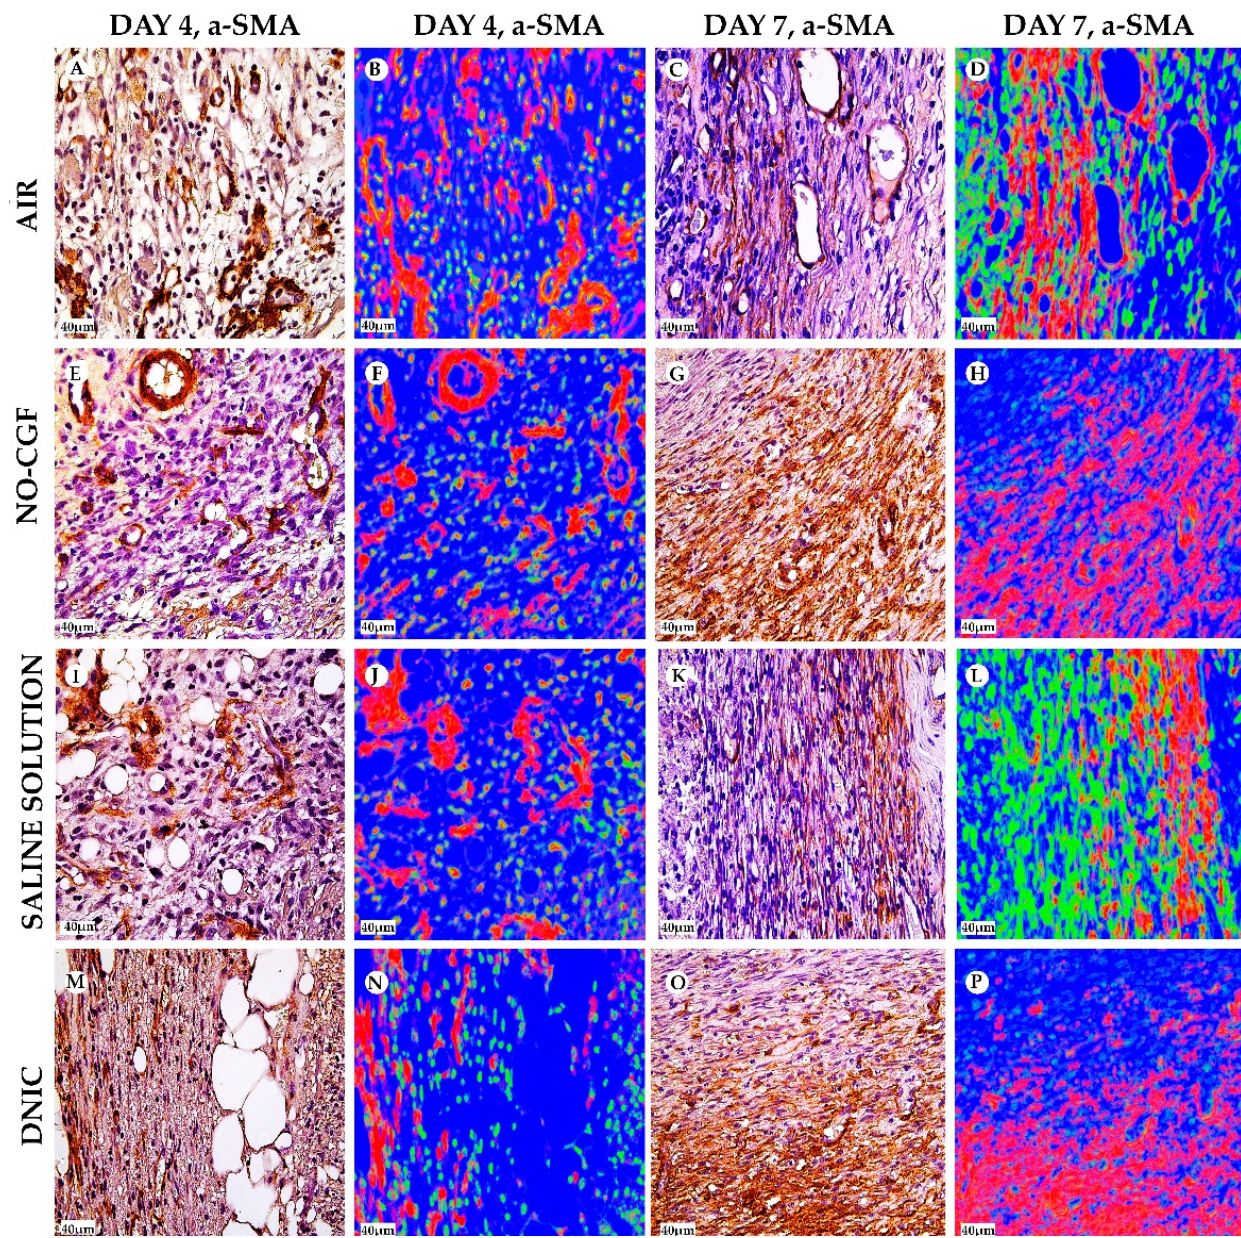
Figure 5. α -SMA expression and α -SMA-positive cells’ distribution in the study groups on days 4 ( A , B , E , F , I , J , M , N ) and 7 ( C , D , G , H , K , L , O , P ), magnification × 400. Red—vimentin-positive cells, green—vimentin-negative cells, blue—background. ( A ) α -SMA expression in endothelial cells, ( B ) well-detected contours of newly formed capillaries, ( C ) cytoplasmic α -SMA expression in the superficial part of the granulation tissue, ( D ) thin layer of red-stained cells, ( E ) singular spindle-shaped α -SMA-positive cells, ( F ) predominance of green-stained cells, ( G ) diffuse α -SMA expression, ( H ) numerous parallel orientated red cells, ( I ) immature granulation tissue with α -SMA expression in endothelium, ( J ) chaotically arranged blood vessels with red-stained walls, ( K ) α -SMA-positive cells in deep part of wound, ( L ) thin layer of positive-stained cells, ( M ) α -SMA-positive cells along the fibrin fibers and ( N ) red-stained cells in superficial part of wound, ( O ) diffuse α -SMA staining in the deep part of wound, ( P ) a thick layer of α -SMA-positive cells.